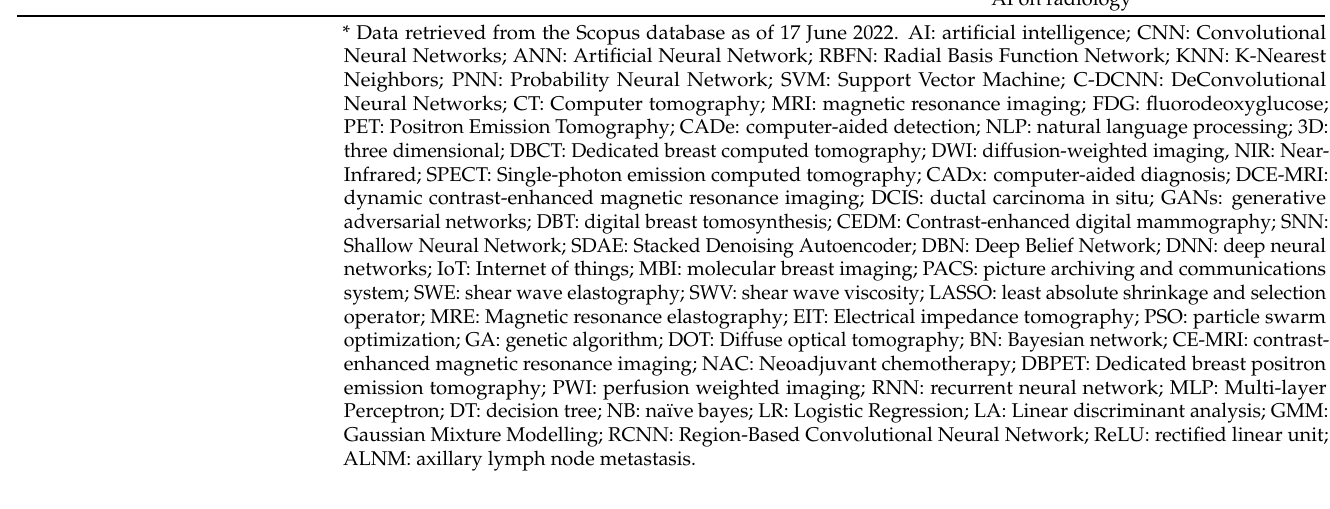
Table A2. AMSTAR rating for each included review work (systematic